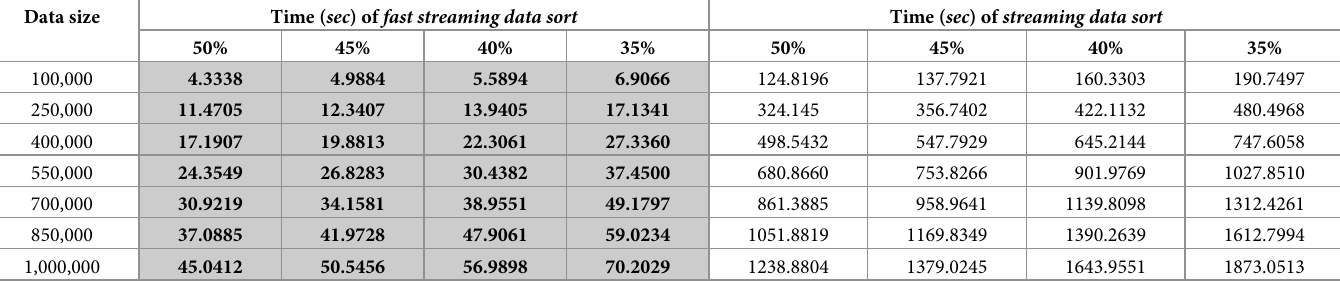
Table 3. Comparison of sorting time between fast streaming data sort and streaming data sort when varying different sizes of working memory in terms of the per- centages of total amount of data. Data size